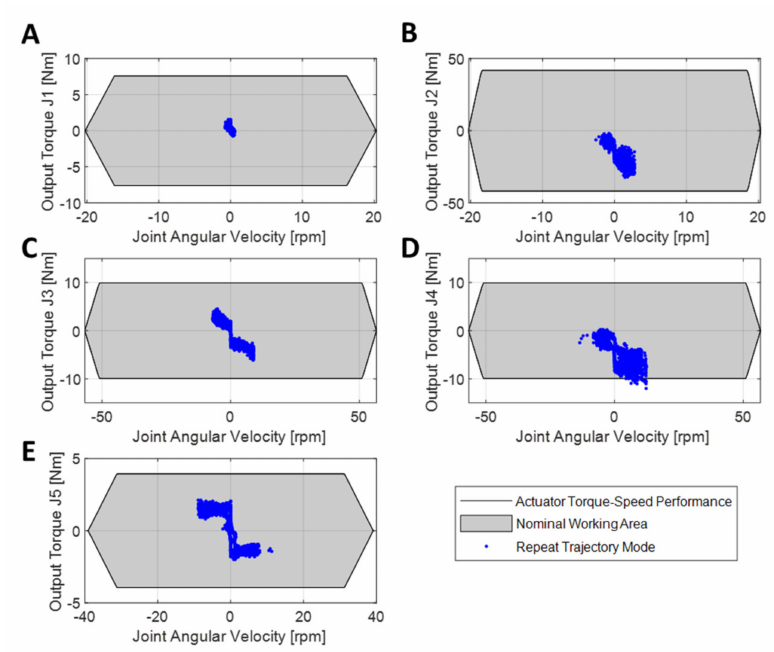
Figure 14. Experimental evaluation of the Float exoskeleton performances with respect to the actuator torque-speed envelopes for each joint under a challenging Repeat Trajectory mode exercise. ( A – E) Torque speed for